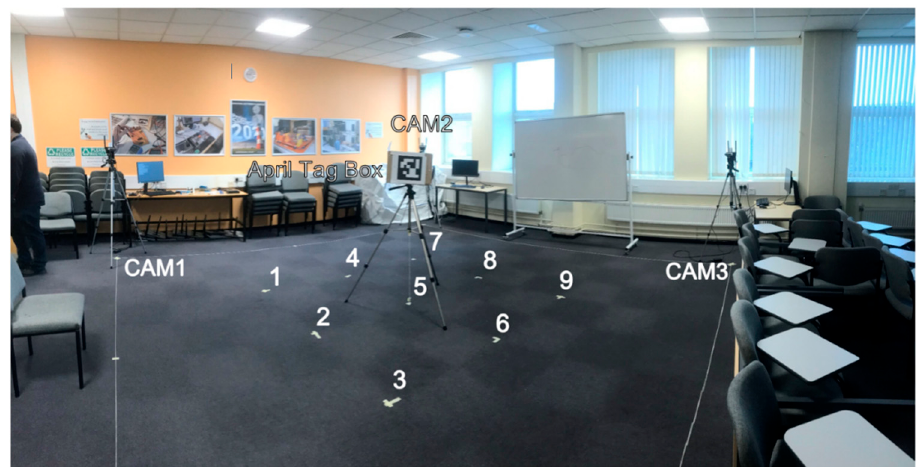
Figure 8. Annotated Test Area.